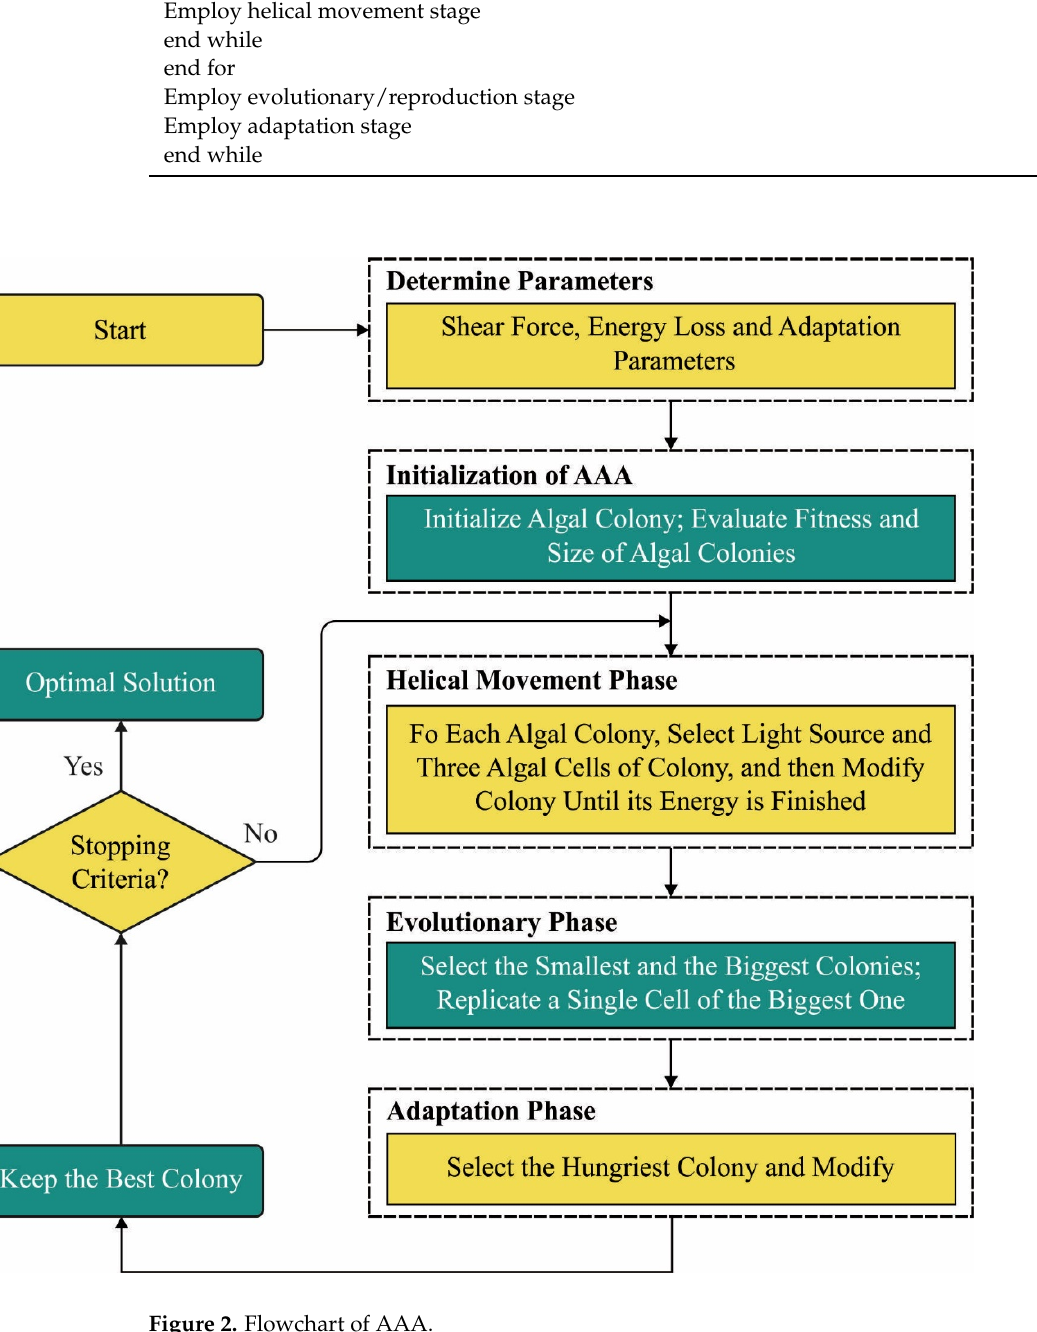
Figure 2. Flowchart of